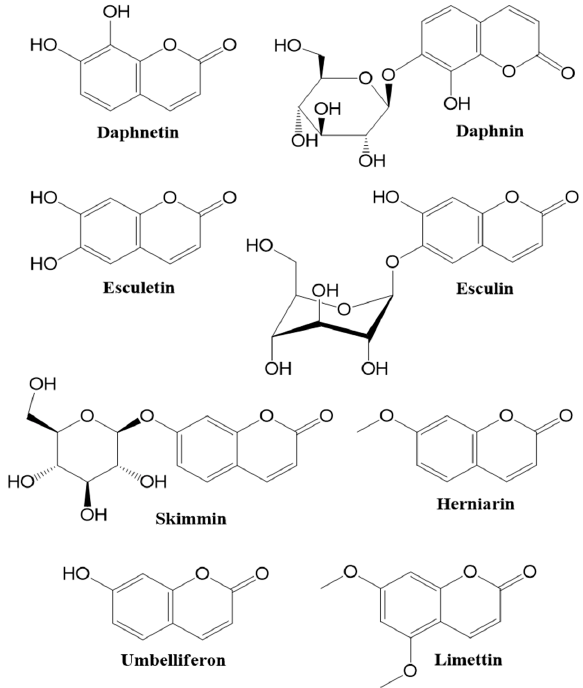
Figure 1. Chemical structures of some simple coumarins.